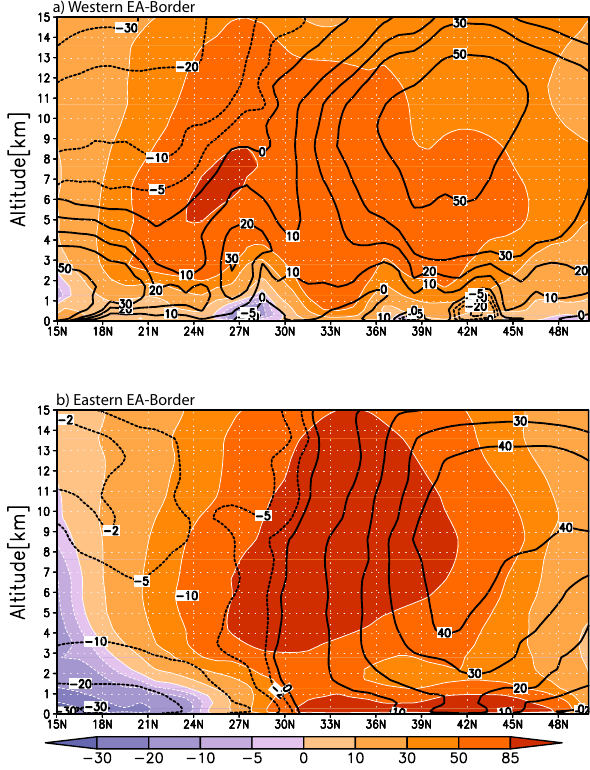
Fig. 4. Same as in Fig. 3, but for the EU-region. Fig. 5. Same as in Fig. 3, but for the